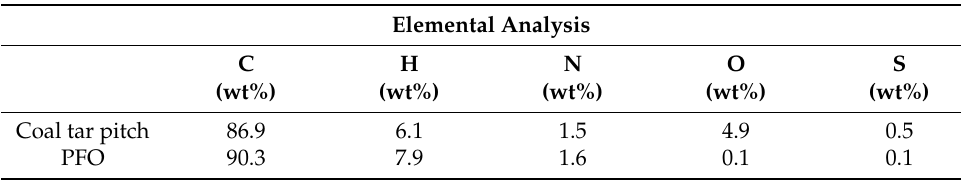
Table 1. Elemental analysis of raw